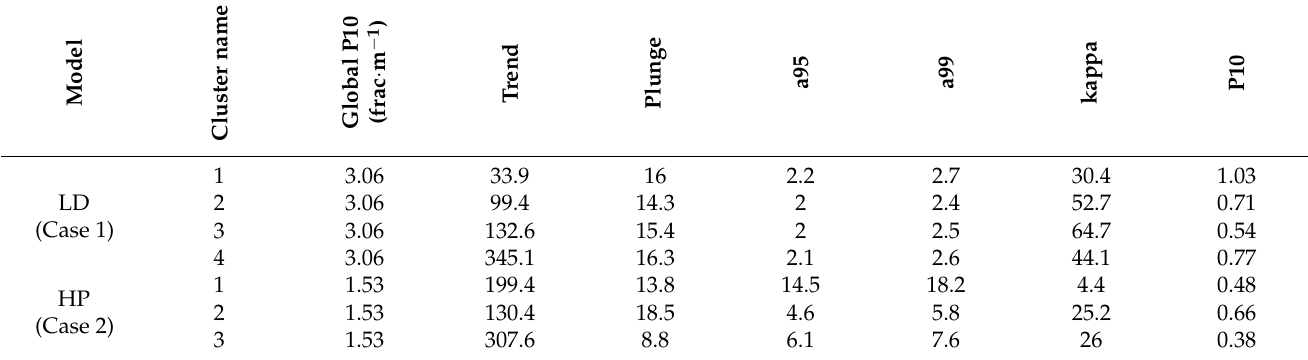
Table 4. Fracture network cluster inputs selected for the stochastic DFN models simulated.